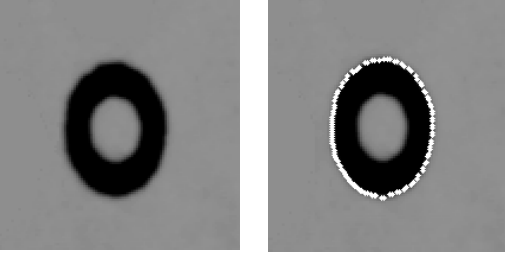
Figure 5. Concentric target ( left ) and its sub-pixel edge positioning result (( right ), taken cylindrical for example).